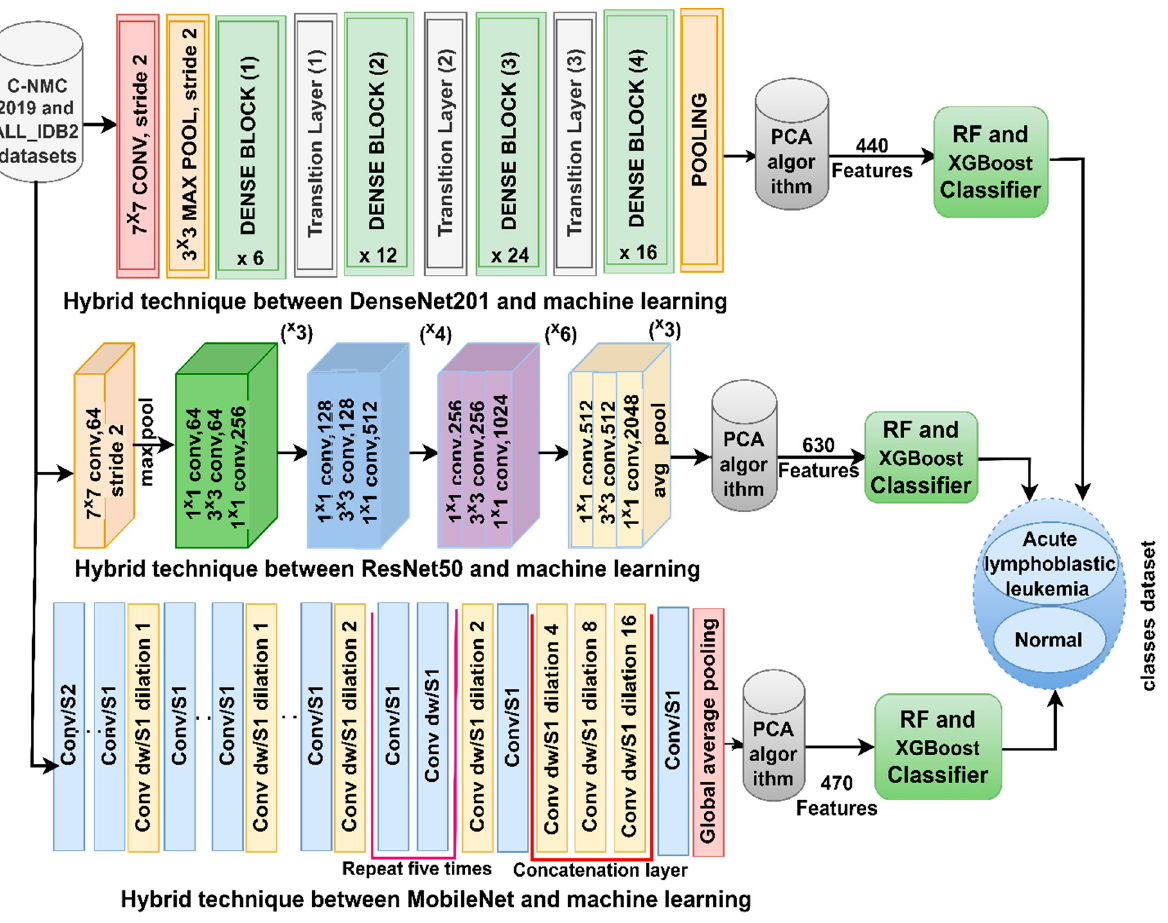
Figure 5. Framework of a hybrid technique between CNN and deep learning for the diagnosis of ALL.